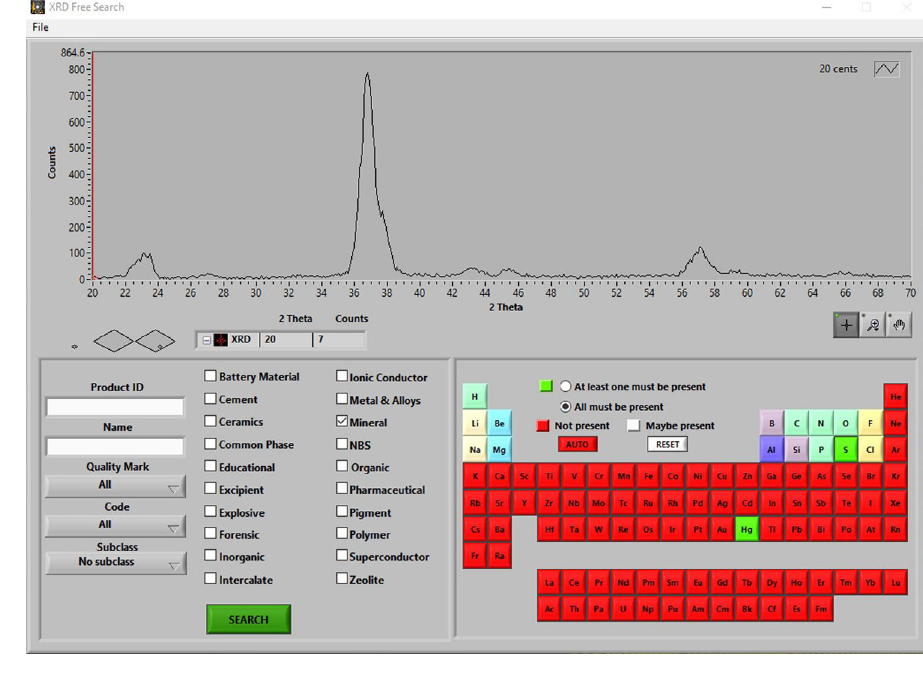
Fig. 5 The XRD free search surface